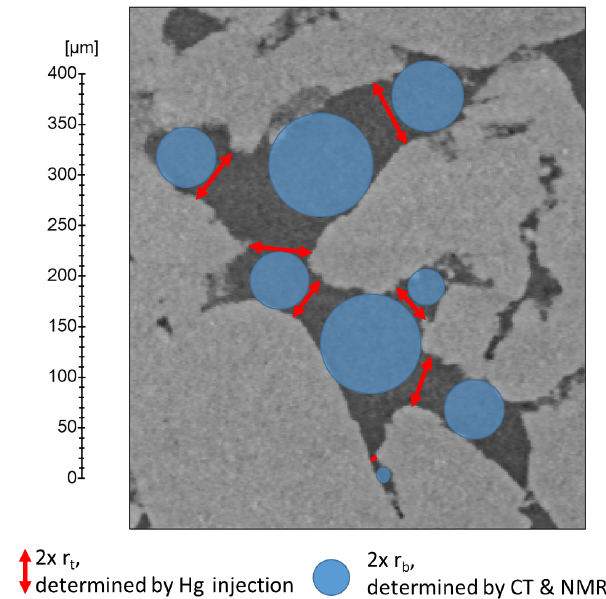
Figure 1. Zoomed-in 2-D slice view of sample BH5-2 in order to visualize pore bodies (blue circles, detected by NMR and digital image analysis (DIA) of µ -CT data) and pore throats (red lines with arrows, detected by